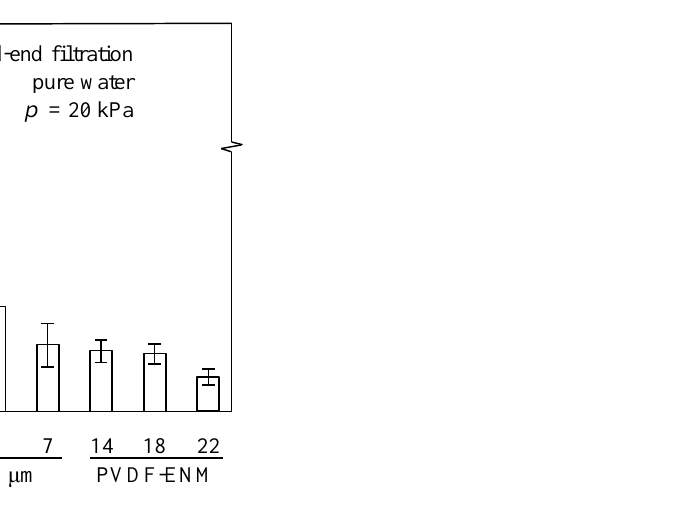
Figure 4. Membrane resistance ( R m ) obtained via the dead-end filtration of ultrapure water at a filtration pressure ( p ) of 20 kPa. Millipore ultrafiltration membranes (MWCO = 10 and 100 kDa), Advantec filter paper (4 and 7 μm), and the prepared PVDF ENMs (PVDF mass fractions of 14, 18, and 22 wt.%) were evaluated.